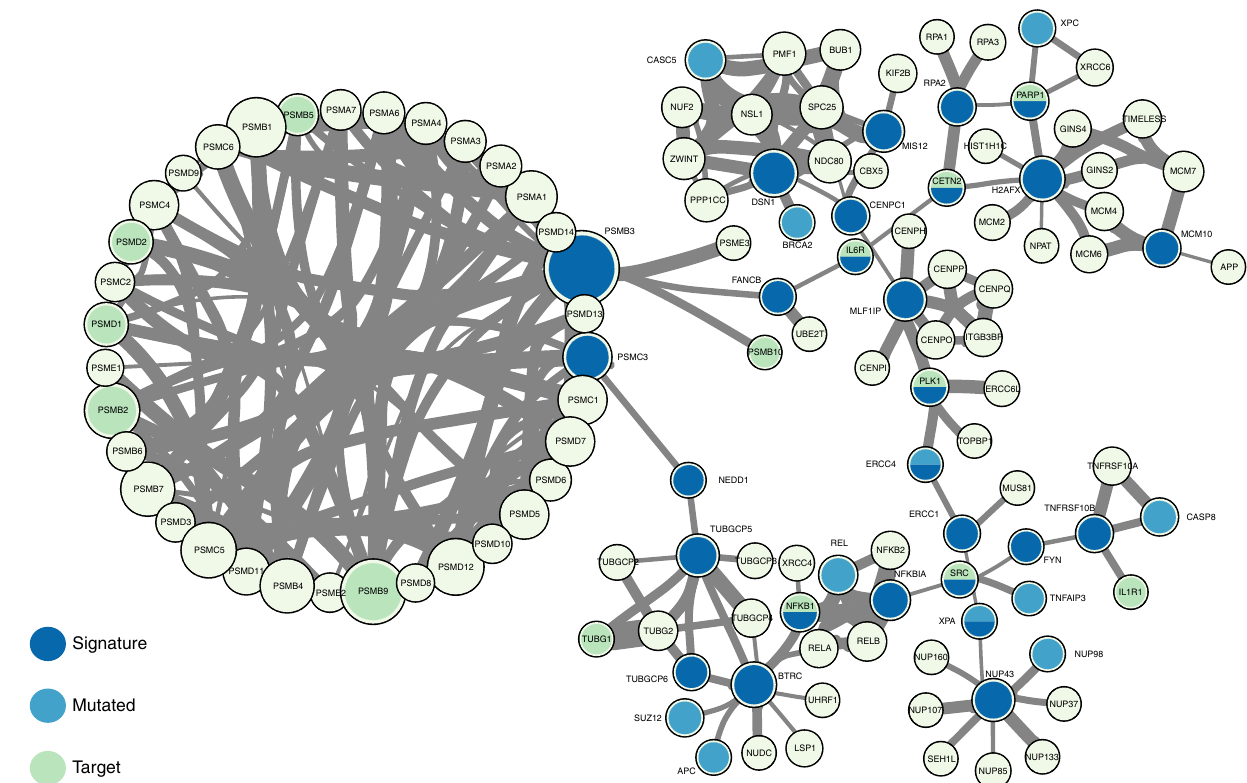
Fig. 2 Network context of cluster 2 signature genes. Network composed by the fi rst neighbours of cluster 2 signature genes in the BioPlex-Ontocanco network. Node sizes are proportional to their degree in the network and edge thickness is proportional to the normalized (CLR) co-expression